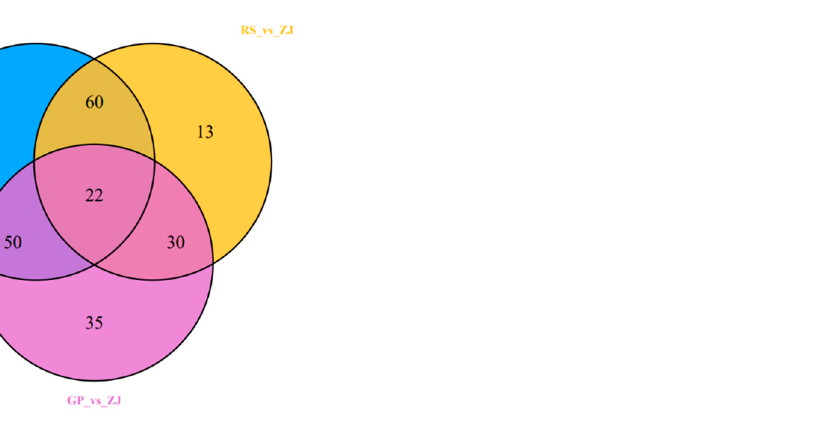
Figure 6. The Venn diagram illustrates shared or unique metabolites that differed significantly in terms of content among the different comparisons.